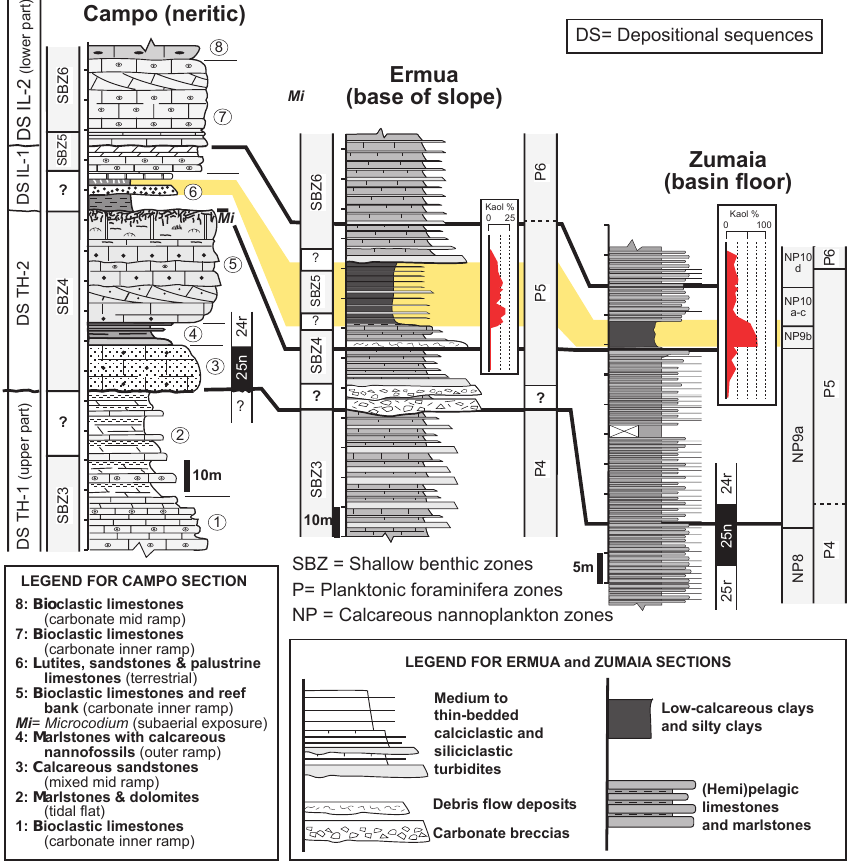
Figure 2. Simplified logs of the Paleocene–Eocene interval of well-studied marine sections of the Pyrenees in which the PETM has been identified (highlighted). Biostratigraphic zonations, the position of Chron C25n and graphs of kaolinite abundance are also